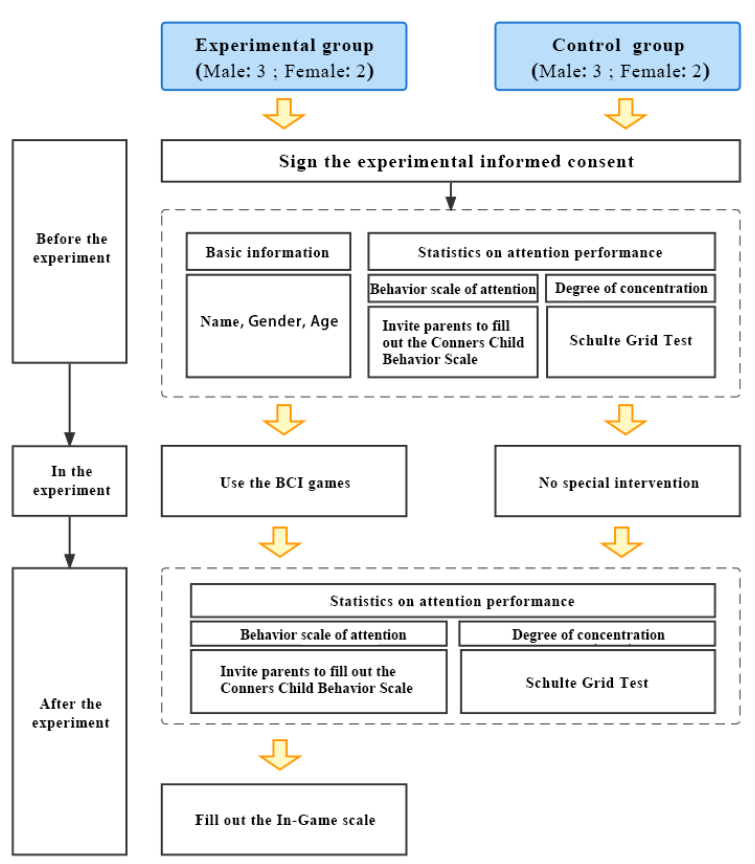
Figure 17. Experiment process.